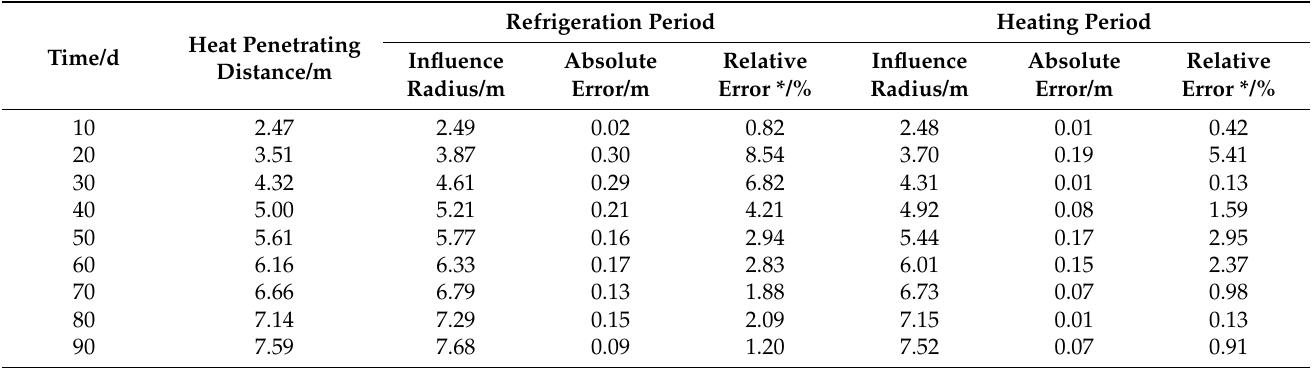
Table 3. Comparison table of the calculated heat penetration distance and simulated influence radius during the refrigeration and heating periods under the operation of a single BHE.